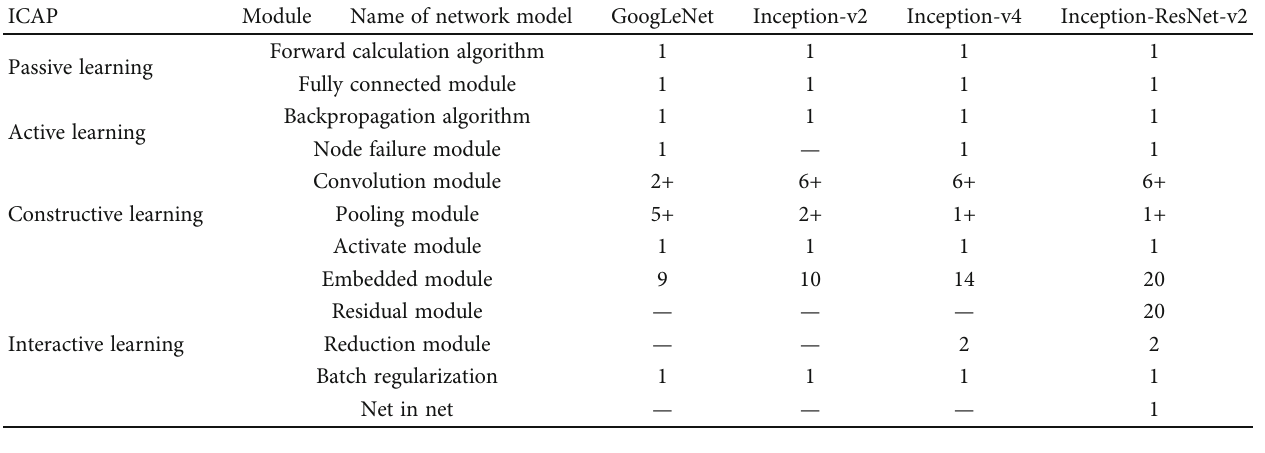
Table 2: Usage statistics of adaptive neural network module (constituent elements).